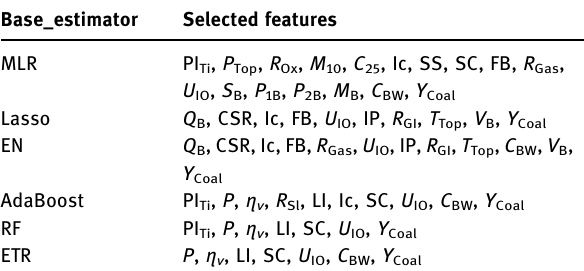
Table 3: The optimal feature sets in RFE based on the base_estimators